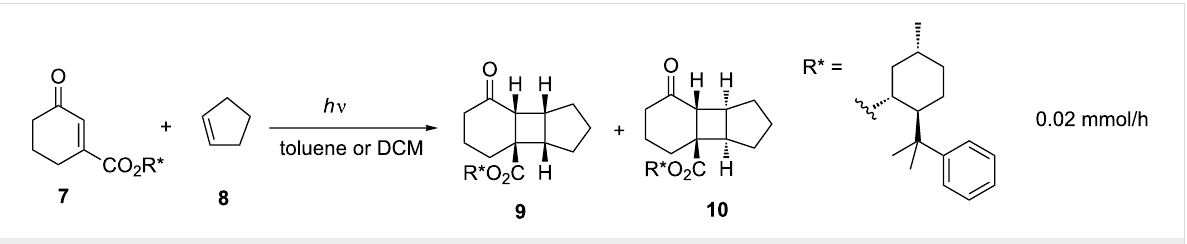
Scheme 3: Diastereocontrolled cycloaddition of a cyclic enone with cyclopentene.